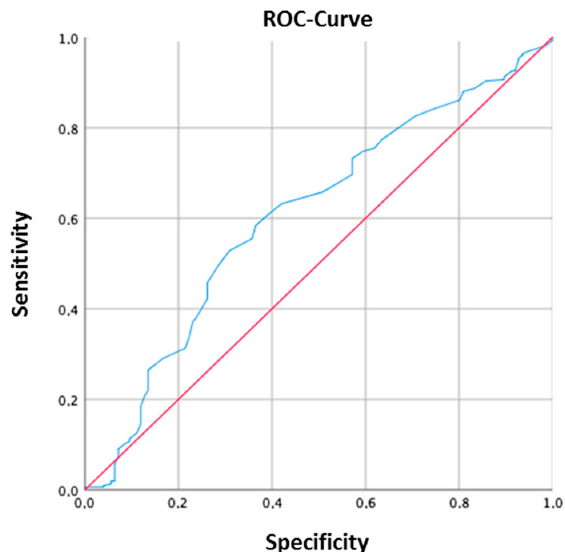
Figure 1. Area under the receiver operating characteristic curve (AUROC) of vitamin D serum levels predicting the risk of flare in IBD patients. A 25-hydroxyvitamin D (25(OH)D 3 ) serum concentration of 27.5 ng/mL was identified as the optimal cut off.